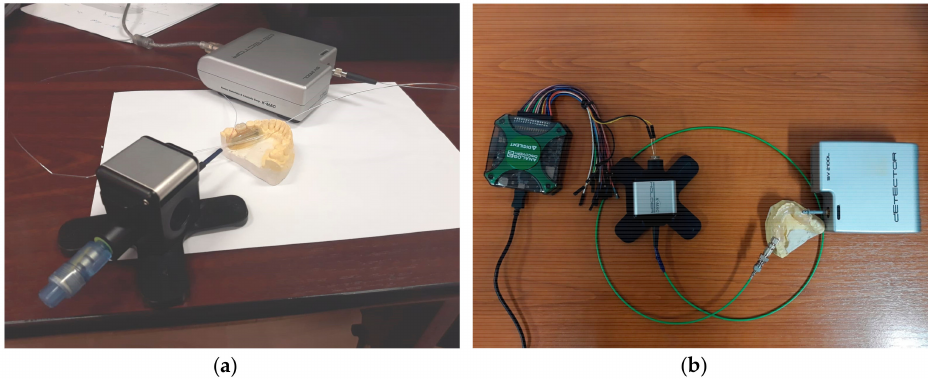
Figure 6. The intra-oral optical sensor test setup for wine color analysis: ( a ) point sensor test setup, and ( b ) extended sensing area sensor test setup.